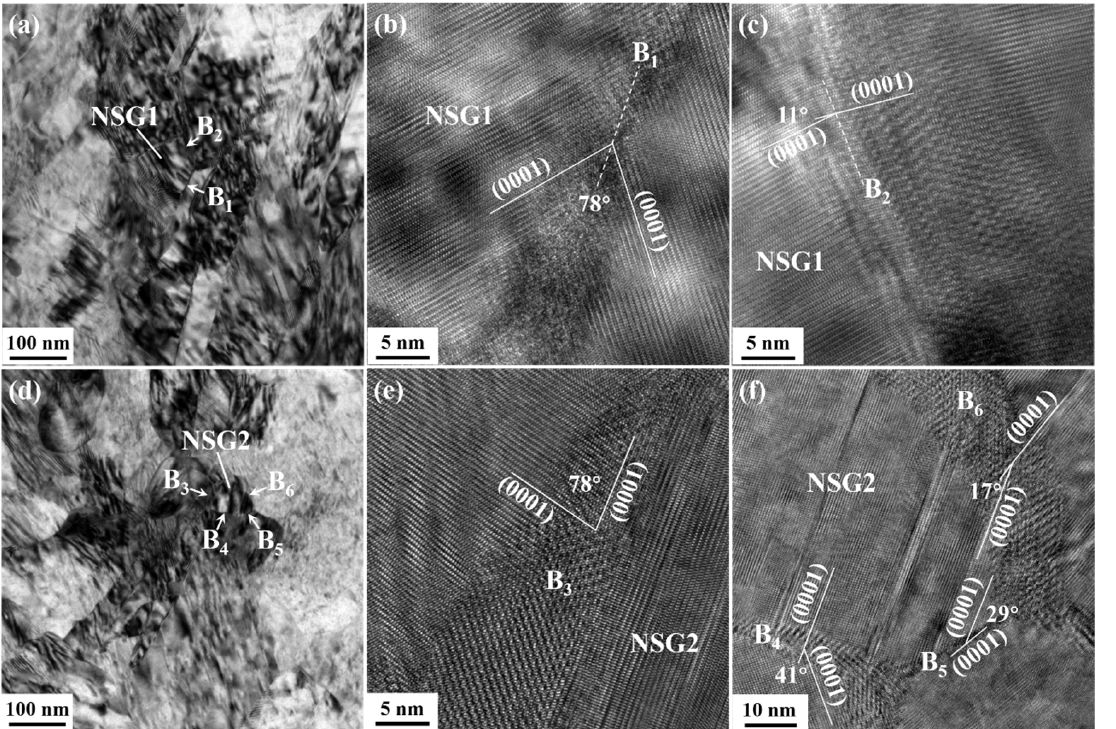
similar features.